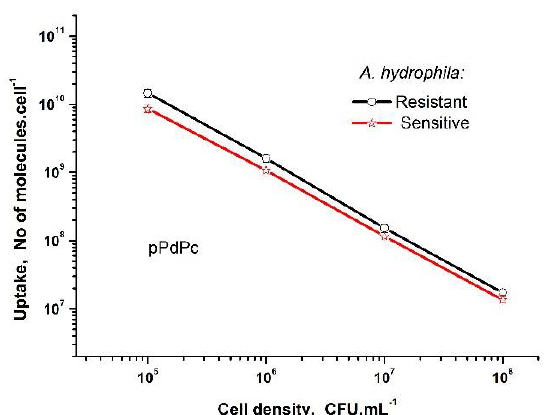
Figure 3. Uptake of Pd(II)-phthalocyanine (pPdPc) in A. hydrophila ( R and S ) strains as suspensions with different cell densities as obtained by fluorescence measurements.